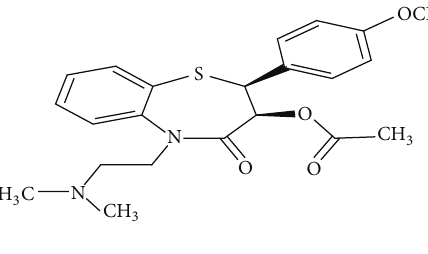
Figure 1: Diltiazem.